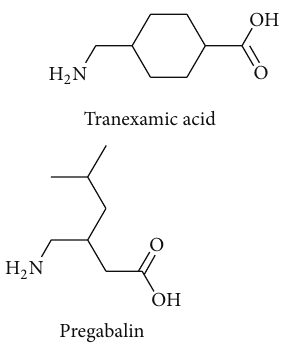
Figure 1: Structure of PG and